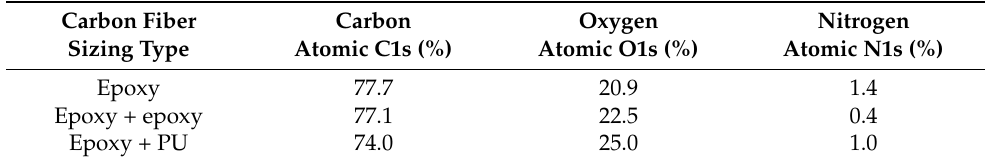
Table 1. The atomic contents existing on the surfaces of (epoxy) single-sized and (epoxy + epoxy) and (epoxy + PU) dual-sized carbon fibers measured by XPS.